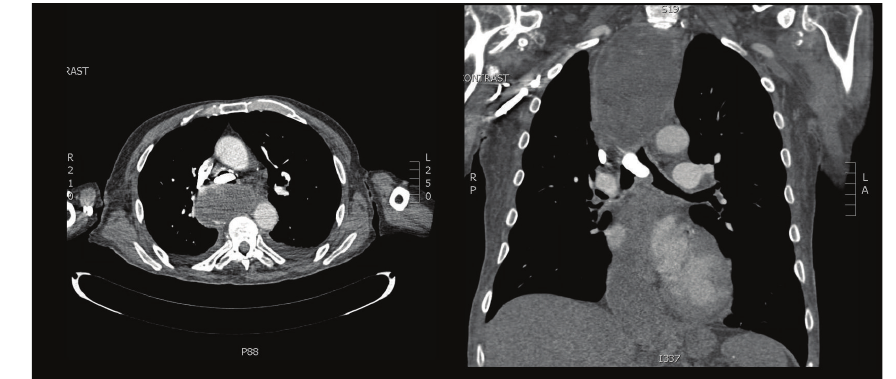
Figure 1: CT chest showing foreign body.